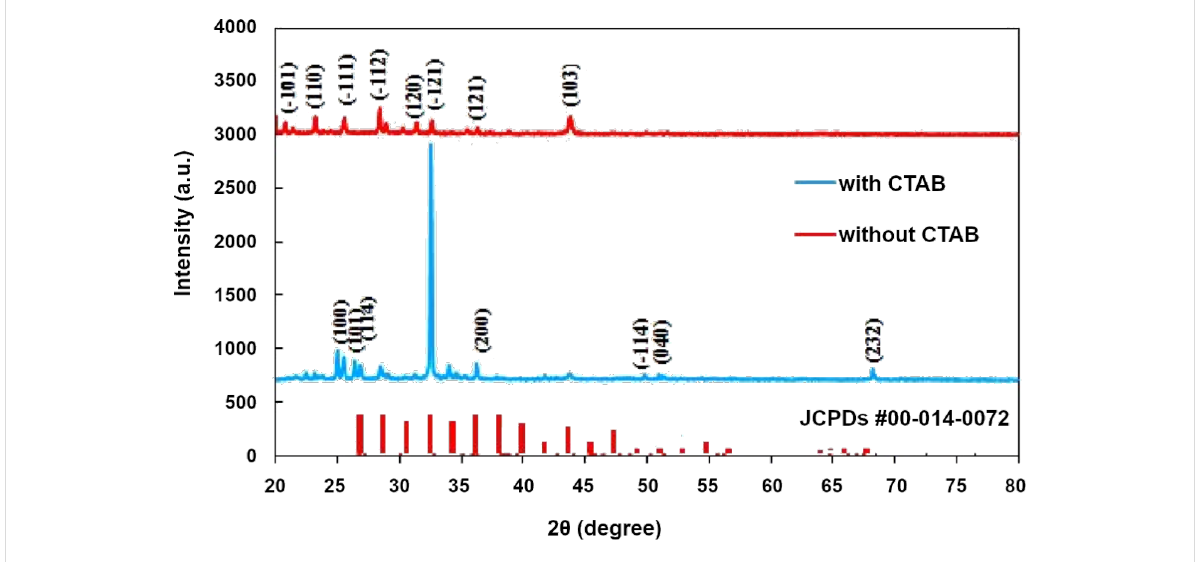
Figure 3: XRD patterns of monoclinic Ag 2 S NPs synthesised with CTAB and without CTAB. The XRD lines are represent the XRD pattern of Ag 2 S powder (JCPDs #00-014-0072).